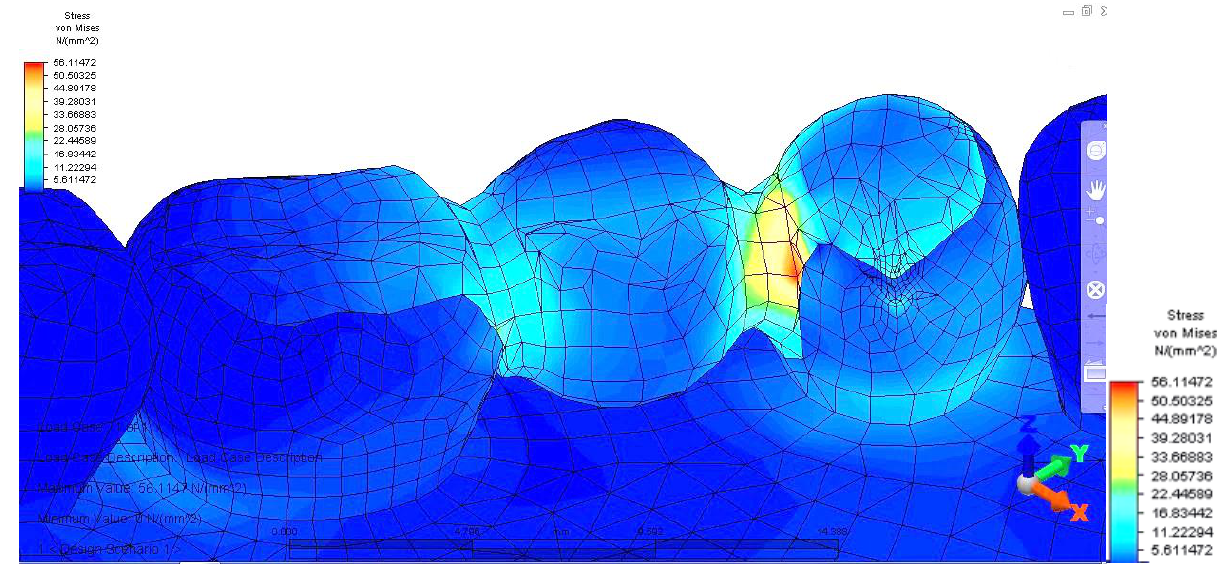
Figure 9. Tension distribution at the bridge when the reaction force is placed in the 3.4 area.